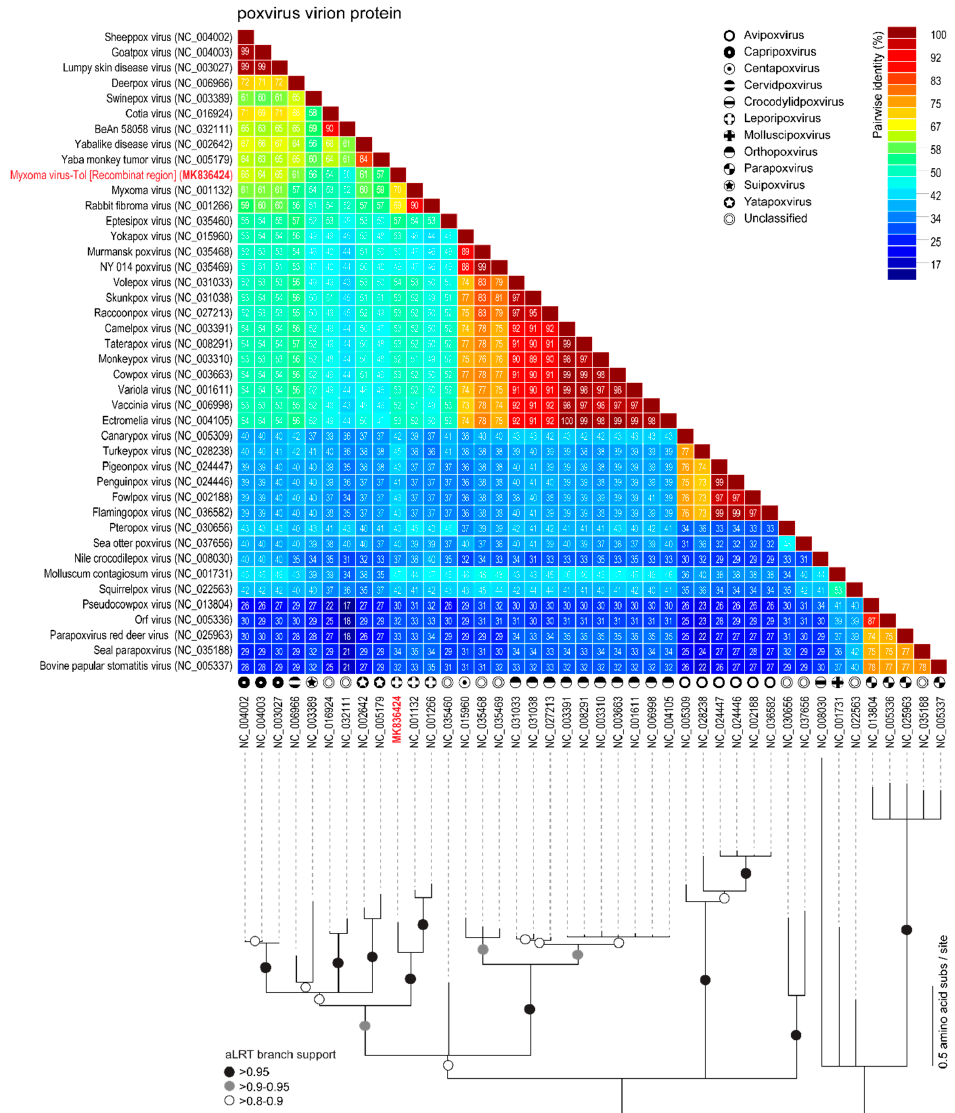
Figure 5. Pairwise amino acid identity matrix (upper image) and maximum-likelihood phylogenetic tree (model JTT+G), showing the relationships of the rPox-virion protein (highlighted in red) found in the recombinant region of MYXV-Tol and its homologous proteins, found in representative sequences (NCBI RefSeq) of poxvirus. Branches with aLRT support of 0.95 are indicated by black circles whereas branches exhibiting 0.9–0.95 and 0.8–0.9 are indicated by grey and white circles, respectively.